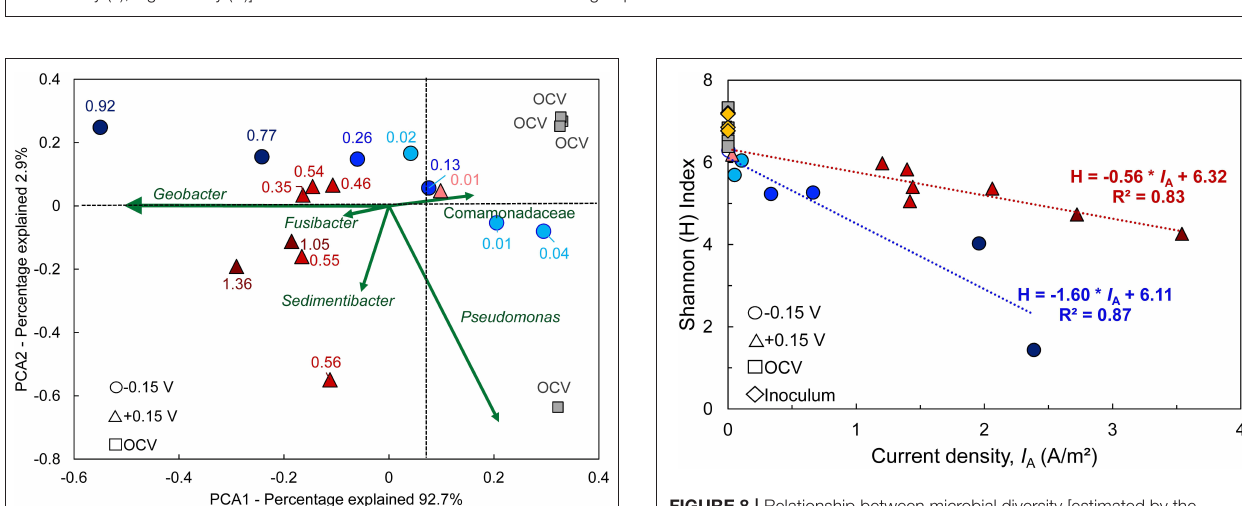
FIGURE 6 | Community composition of the bioanode biofilms fixed at (A) − 0.15V and (B) + 0.15V. The replicates for each anode potential are ordered from lowest to highest current density ( I A ) recorded at the end of the startup cycle and are categorized according to their activity level during the startup cycle [Inactive (N), low-activity (L), high-activity (H)]. Genera with a relative abundance < 5% are grouped into “Other”.